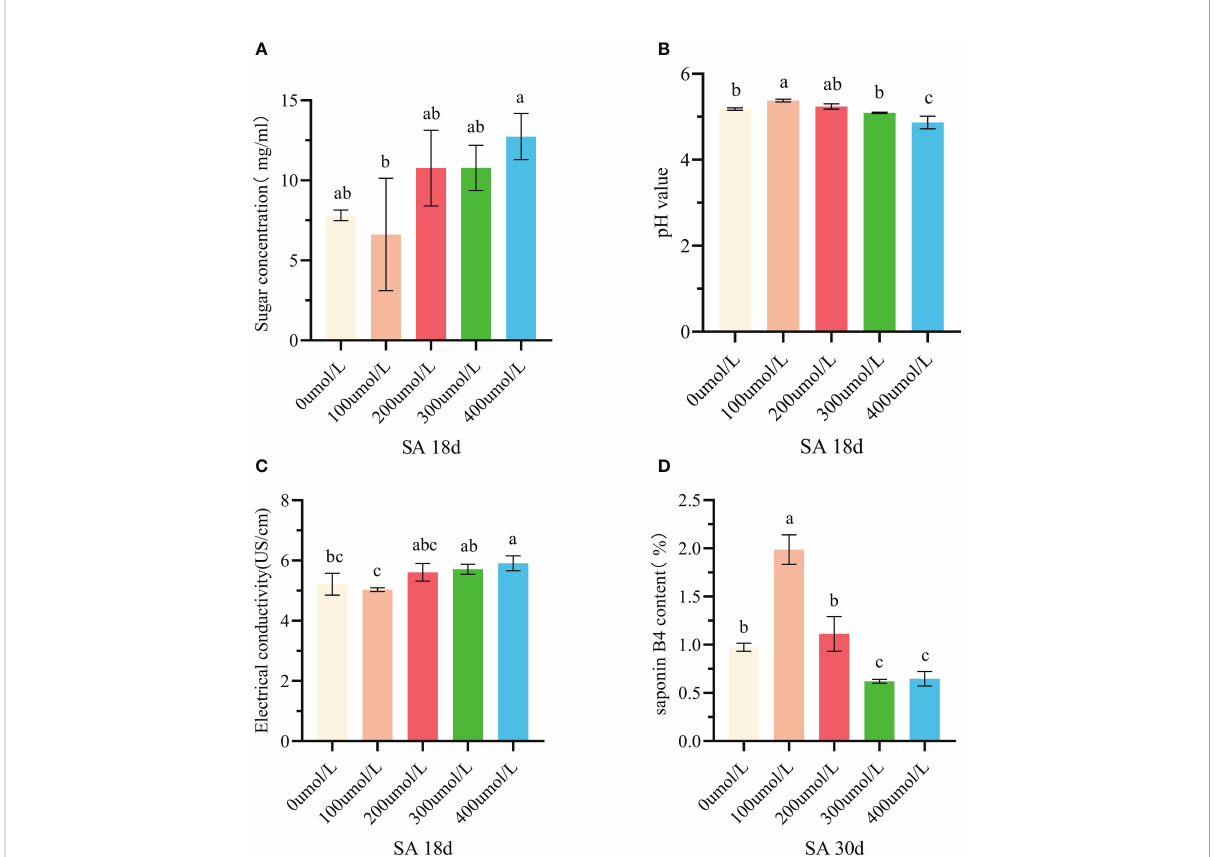
FIGURE 2 Effects of salicylic acid on callus growth and accumulation of saponin B4 at different stages. (A) Change of sugar concentration in culture medium after adding salicylic acid for 18 days; (B) Change of pH value in culture medium after adding salicylic acid for 18 days; (C) Change of conductivity in culture medium after adding salicylic acid for 18 days; (D) Changes of saponin b4 content in callus after adding salicylic acid for 30d of culture. Note: There was no signi fi cant difference between the same lowercase English letters (p>0.05). There was signi fi cant difference between the different lowercase English letters (p<0.05)